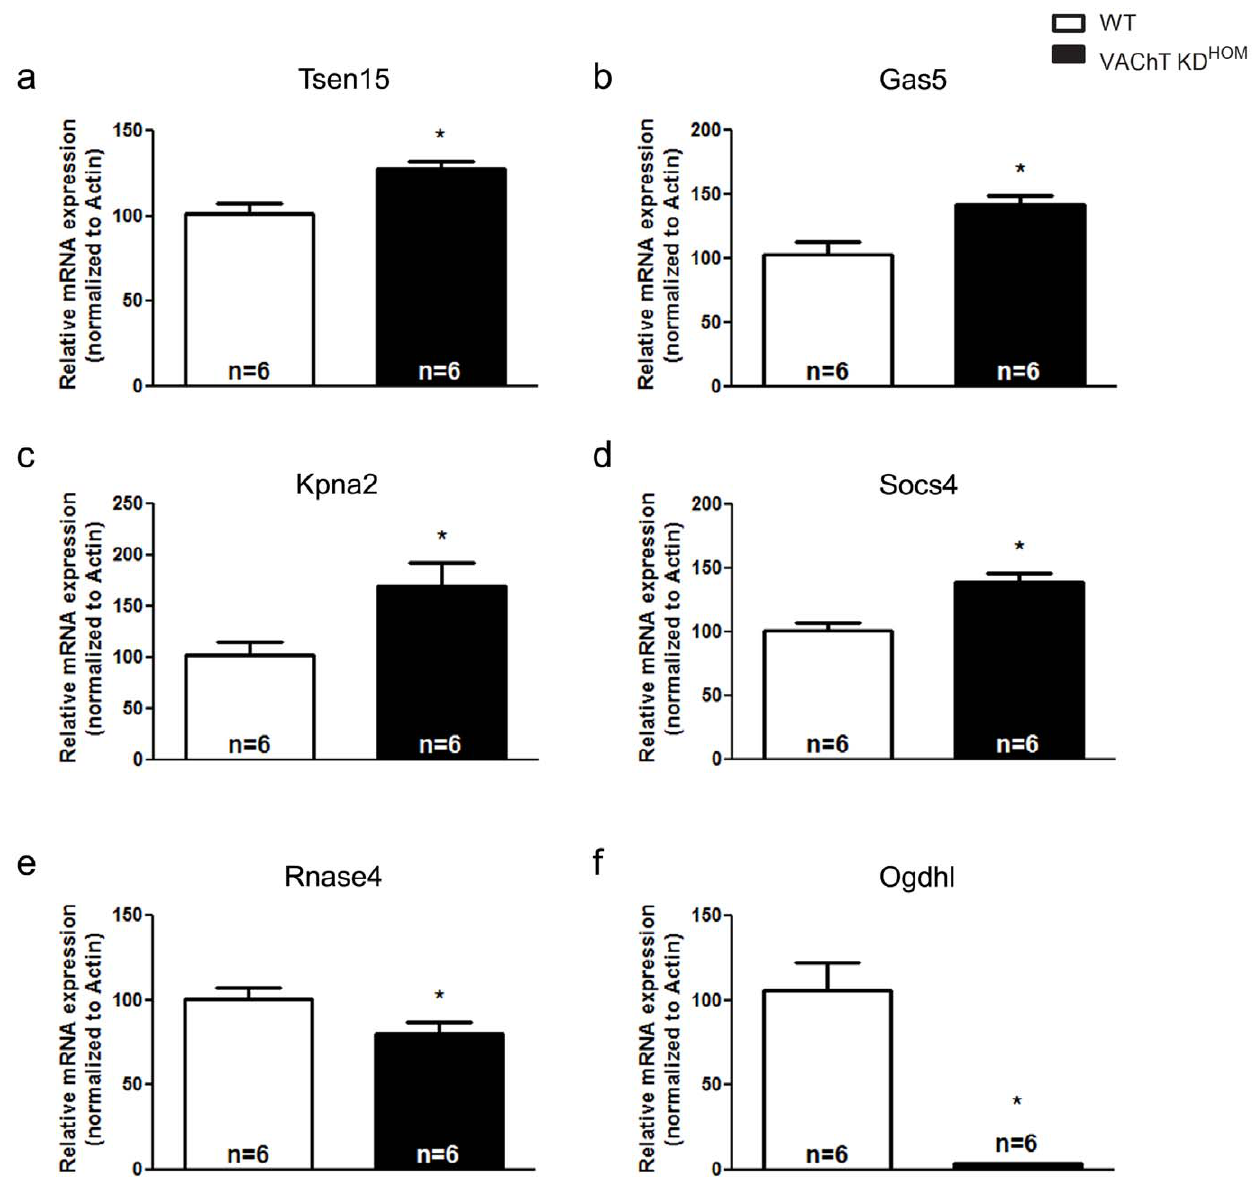
Figure 1. qPCR analysis confirms the expression pattern of several genes detected in the microarray analysis. mRNA expression of tRNA splicing endonuclease 3 (Tsen15; panel a ), Growth arrest specific 5 (Gas5; panel b ), karyopherin alpha 2 (Kpna2; panel c ) and suppressor of cytokine signaling 4 (Socs4; panel d ) was increased in mutant mice. mRNA analysis of ribonuclease, RNase A family 4 (Rnase4; panel e ) and oxoglutarate-dehydrogenase like (Ogdhl; panel f ) confirmed transcriptional downregulation in whole heart RNA from the mutant animals. Data represent the mean 6 SEM, with n indicated within bars. *p , 0.05 versus wild-type mice.